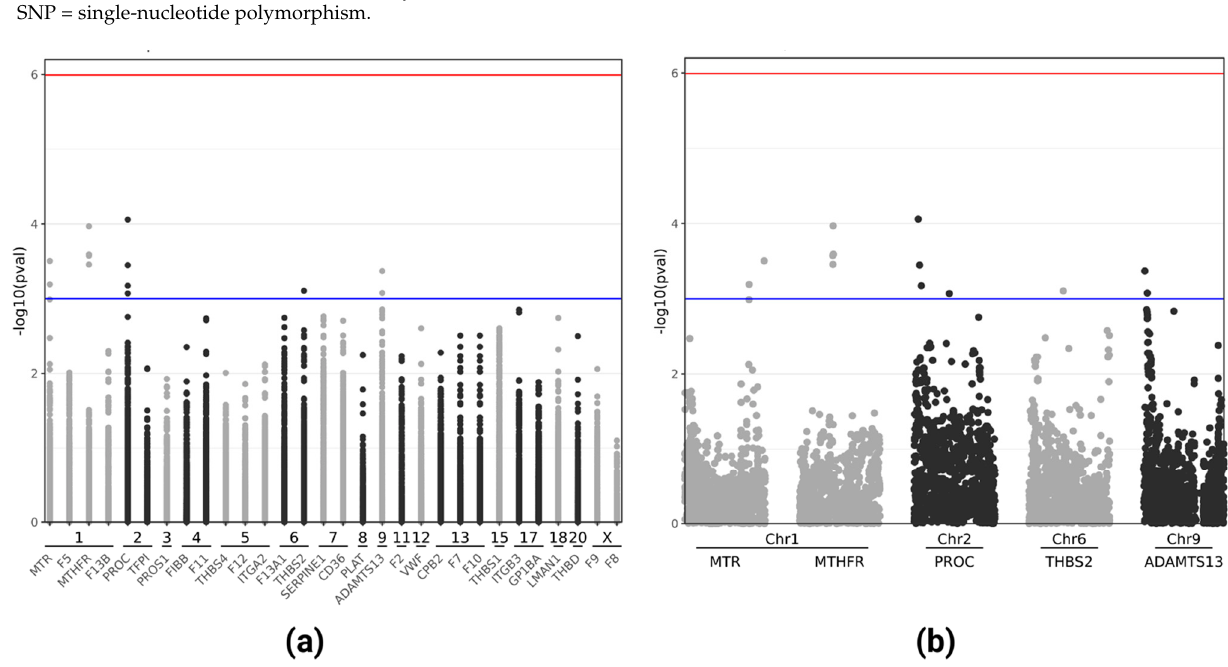
Table 3. Association results for functional SNPs in F5 , F2 , and F13A1 .